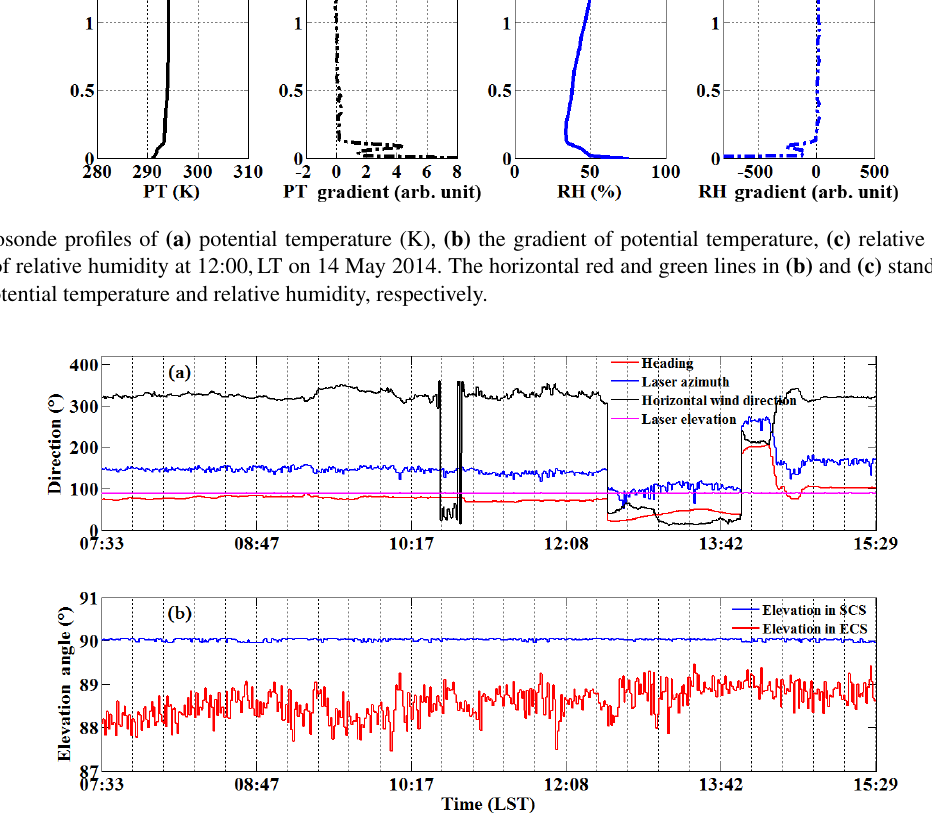
Figure 11. Measurement from 07:33 to 15:29LT on 14 May 2014 of the (a) time series of ship heading, CDL laser beam azimuth and elevation in the Earth coordinate system, and horizontal wind direction at 0.4km. (b) Elevation angle in zenith stare mode in Ship Coordinate System and Earth Coordinate